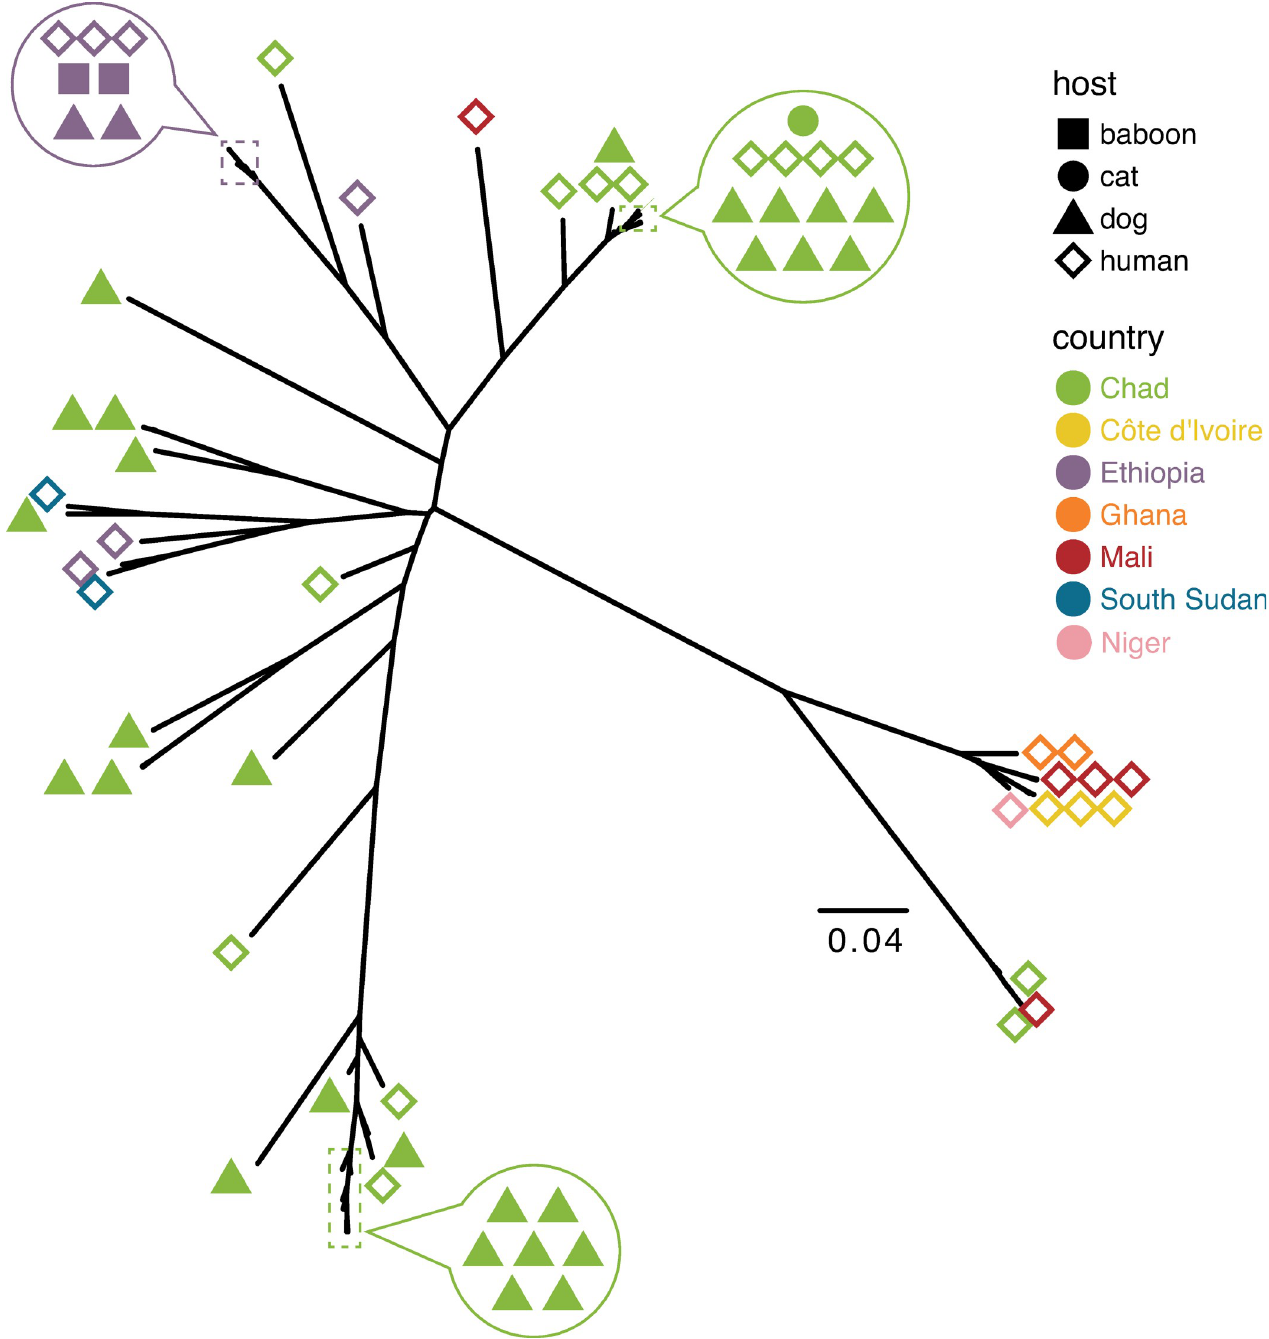
Fig 3. Phylogenetic tree based on inferred mitochondrial genome sequences for 65 Dracunculus medinensis samples for which sufficient coverage of the mitochondrial genome was available. For clarity, arrowed circles show host and geographic origin for samples with very similar mitochondrial haplotypes.